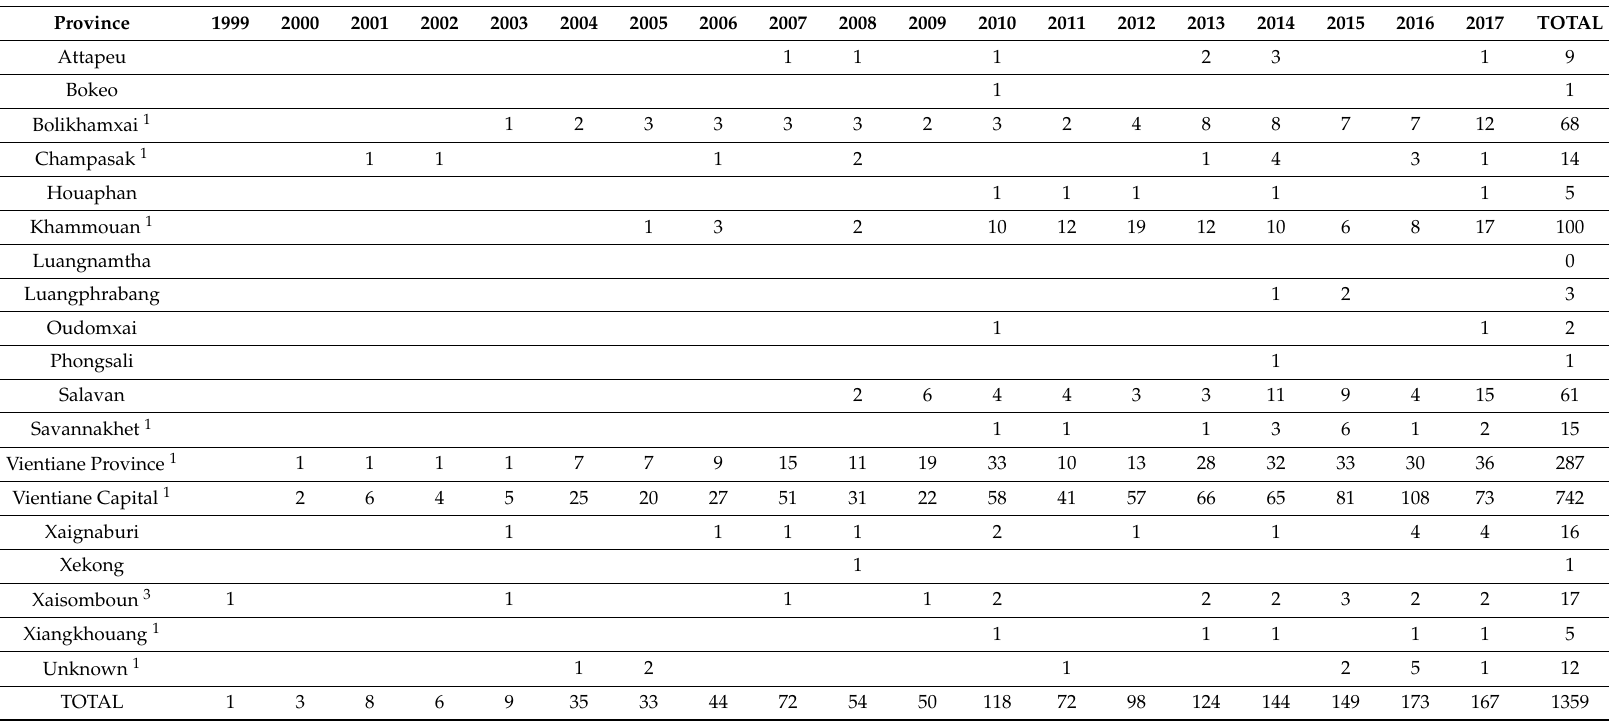
Table 1. Cases of culture-positive melioidosis diagnosed in Laos 1,2